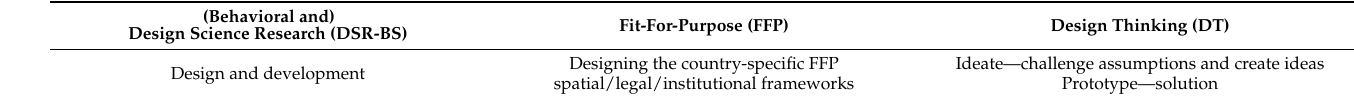
Table 7. Extract of the design process